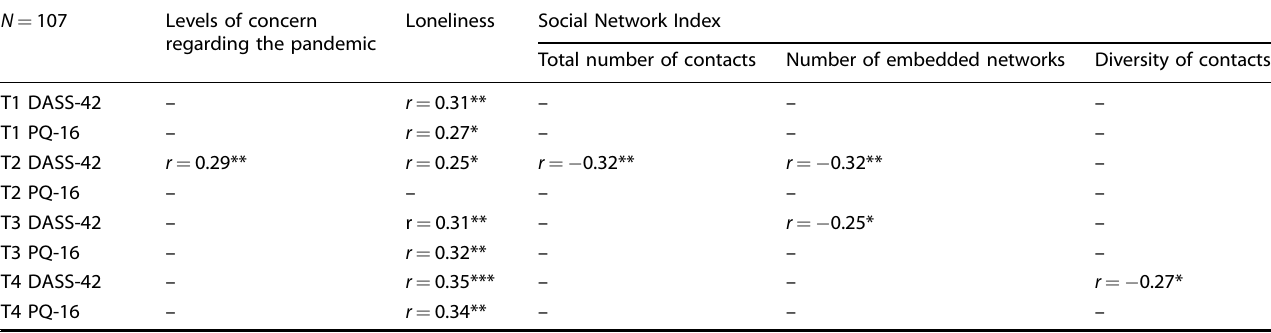
Table 5. Correlations between the DASS-42 and PQ-16 at the four time points, and various indices of social contacts, and concern regarding the COVID-19 pandemic on corresponding time points. N =